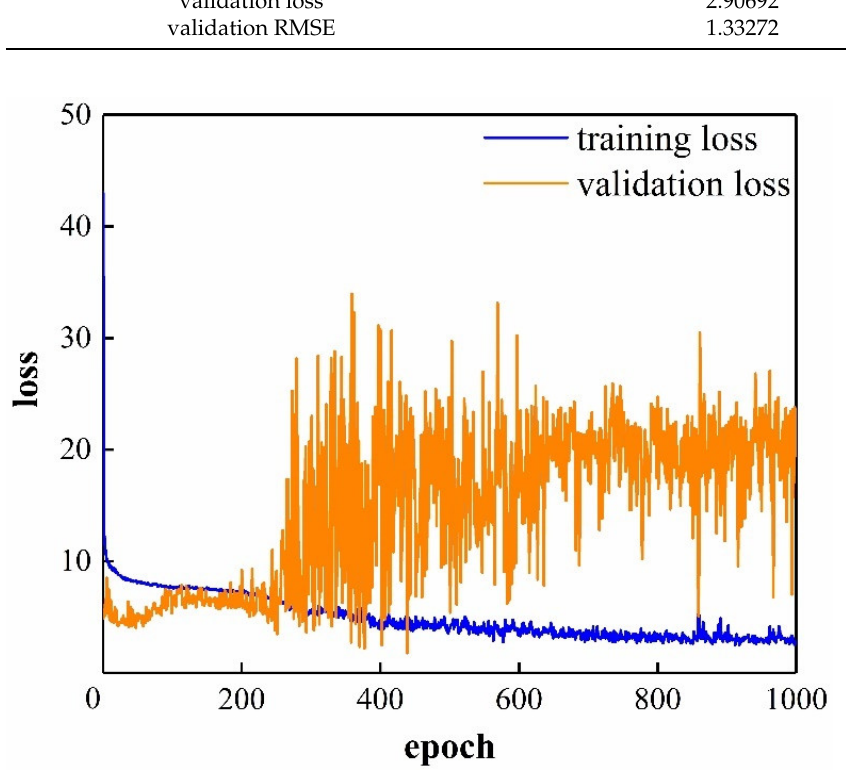
Figure 6. Loss curve of model 4.